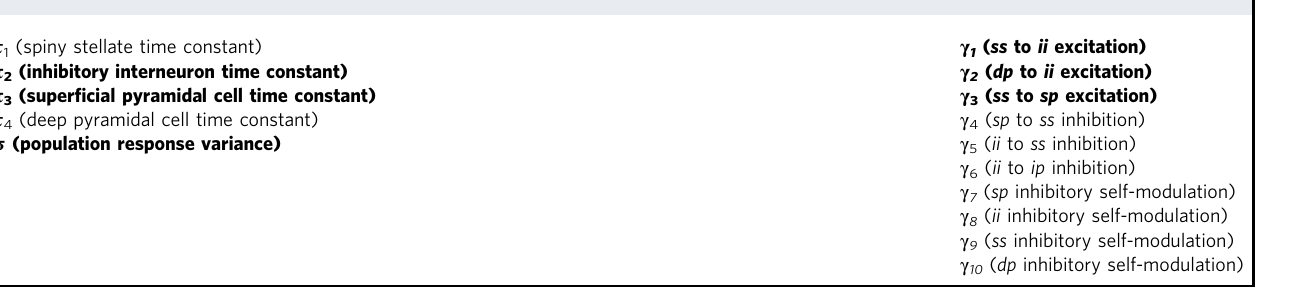
Table 1 Free parameters fi tted by the DCM (parameters related to NMDAR-transmission in